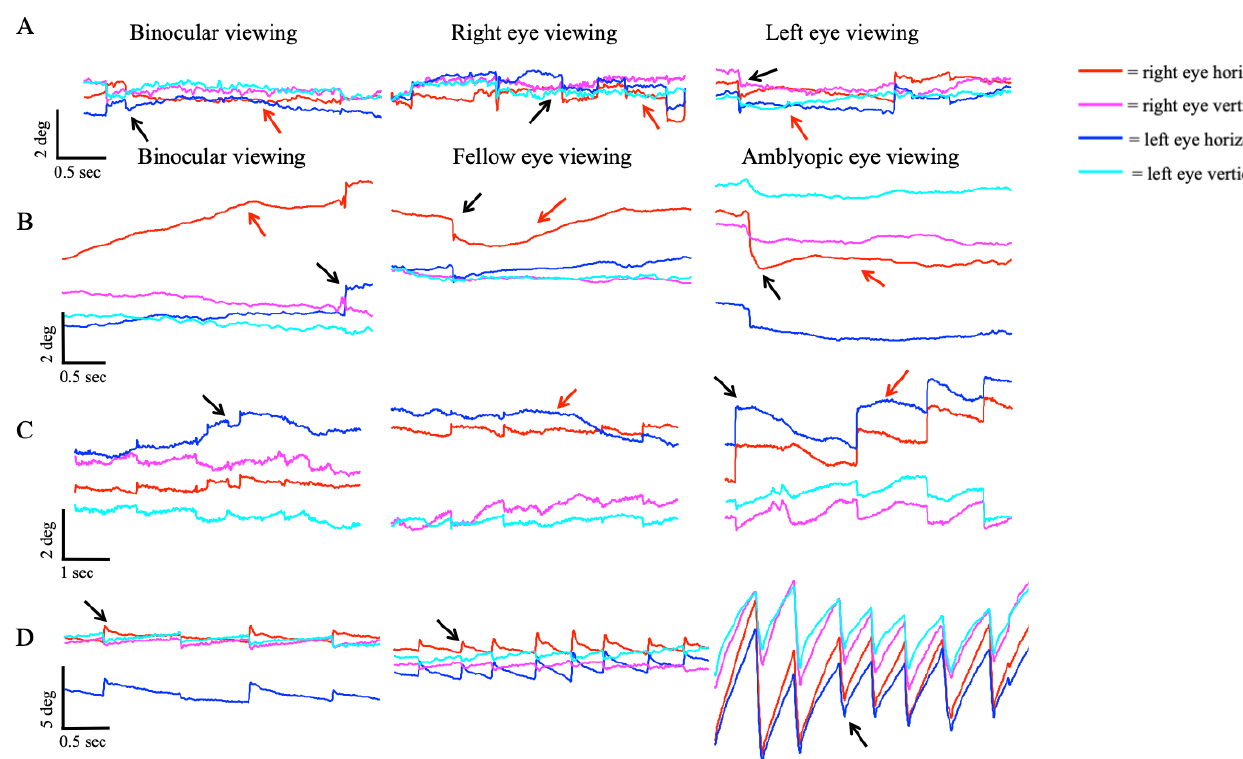
Fig. 1: Representative raw data tracings of fixational eye movements under different viewing conditions in a healthy control (N14) (A), severely amblyopic patient without nystagmus (S23) (B), amblyopic patient with nystagmus but no FMN (S30) (C) and a patient with FMN (S44) (D). In the healthy control (A) the horizontal (red and blue) and vertical eye (magenta and cyan) positions of the right and left eye are plotted on the y-axis while x-axis depicts corresponding time. In patients without nystagmus (B) the blue and cyan traces are horizontal and vertical eye positions of the fellow eye and the red and magenta traces are horizontal and vertical eye position of the amblyopic eye respectively. The black arrows represent fixational saccades whereas the red arrows represent the inter-saccadic drifts. In the patient with nystagmus without FMN (C), the red and magenta traces represent horizontal and vertical eye positions of the fellow eye and the blue and cyan represents horizontal and vertical eye positions of the amblyop- ic eye. The black arrows depict quick phases of the nystagmus and the red arrows depict the slow phases. Fig (D) represents horizontal and vertical eye positions of the fellow (red and magenta) and amblyopic eye (blue and cyan) of patients with fusion maldevelopment nystagmus. The black arrows depict the quick phases of nystag- mus. The positive excursion on horizontal eye position = rightward movement and positive excursion on vertical eye position = downward